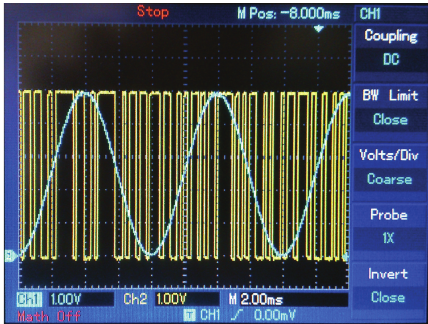
Figure 9: Numbers generated by the logistic map with 𝑟 = 3.9018 and 𝑥(0) = 0.5 .